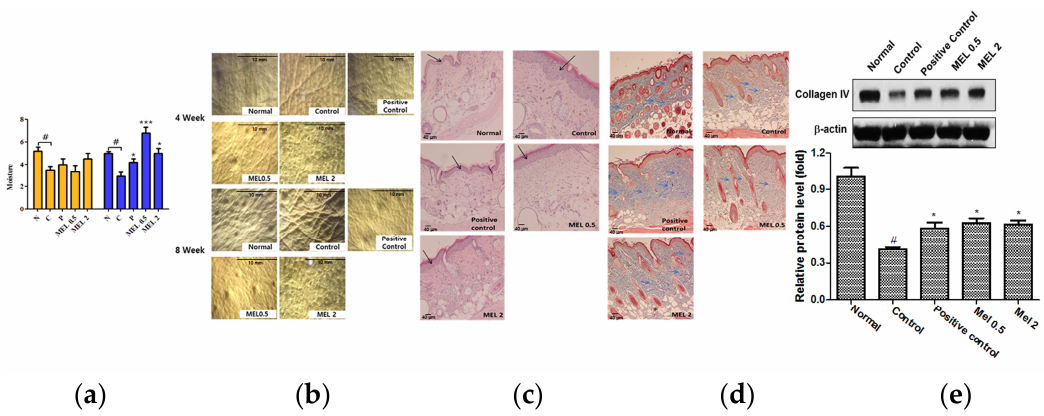
Figure 5. The melatonin significantly suppresses wrinkles and collagen fibers in the dorsal skin of SKH 1 hairless mice. N, Normal; C, Control + UVB irradiation; P, Positive control: Retinoic acid 2 mg/kg + UVB; MEL 0.5, Melatonin 0.5 mg/kg + UVB; MEL 2, Melatonin 2 mg/kg + UVB. ( a ) Effect of melatonin on water loss in the dorsal skin of SKH 1 hairless mice. Data represent means ± SD. *** p < 0.001 and * p < 0.05 versus UVB Control, # p < 0.05 versus Normal control. ( b ) Effect of melatonin on wrinkles in the dorsal skin of SKH 1 hairless mice. Melatonin reduced the degree of wrinkles induced by UVB irradiation on the dorsal skin of SKH1 hairless mice. Images of skin replicas were casted on the dorsal skin surface of mice using SILFLO. Scale bars = 10 mm ( c ) Hairless mouse skin was stained with hematoxylin and eosin ( × 100). Epidermis thickness was measured under light microscopy. Black arrow (epidermis). Scale bars = 40 µ m ( d ) Collagen fiber formation was evaluated using Masson's trichrome staining. Collagen fiber bundles are shown in blue area (Blue arrow) ( × 100) Scale bars = 40 µ m. ( e ) Effect of melatonin on collagen IV expression in UVB-exposed mice skin tissues. Skin tissues were homogenized on ice and the extracts were subjected to Western blotting. Graphs represent the quantitative analysis of protein expression adjusted by β -actin. Data represent means ± SD. * p < 0.05 versus UVB control, # p < 0.05 versus normal control.